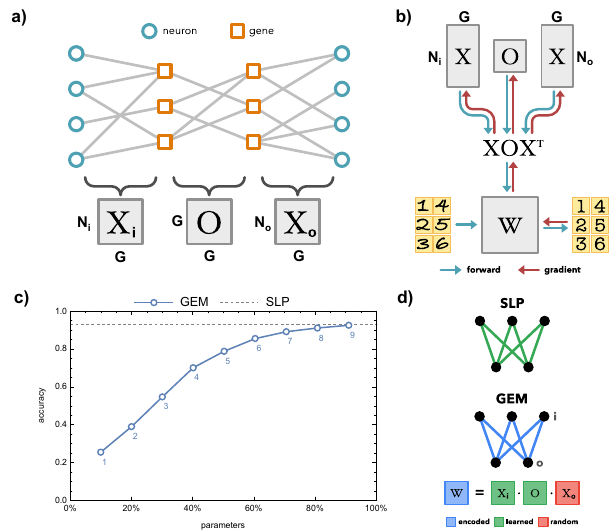
Fig. 1 | The genetic neuroEvolution model. a Visualization of the Genetic Con- nectome Model 18,19 . Matrices X i and X o represent the gene expression of input and outputneurons,respectively.The O matrixcorrespondstothegeneticinteractions that underlie neuronal partner selection. b Traditionally, AI techniques de fi ne an architecture ( W ), which can receive data as inputs (handwritten digits, left of W ), and produce predictions (digital numbers, right of W ). The weights ( W ) of the architecture can be updated (leftward red arrow) based on the distance of the predictions from known values, thereby producing a more accurate system with training. In the Genetic neuroEvolution Model (GEM), the architecture ( W ) is pro- ducedfromasmallsetofwiringrulesde fi nedby X sand O (downwardbluearrows). At each training step, the data is passed through to make predictions (rightward blue arrows). However, rather than altering the architecture weights directly, gra- dients are computed to update X s and O (upward red arrows).Atthe next training steptherevisedwiringrulesgeneratearevised W (downwardbluearrows). c Mean performance of the GEM on the MNIST task. The accuracy of a single-layer linear classi fi er (784 by 10 nodes) is shown, either with learned weights (dashed line) or weightsencodedbytheGEM ’ swiringrules(blueline,withnumberofgeneslabeled below each marker). Parameters are expressed as a percentage of a learned SLP ’ s weights. d Visualization ofalearned SLP and an SLP encodedby the GEMinFig. 1c. We do not learn X o , as we fi nd it adds parameters without increasing task